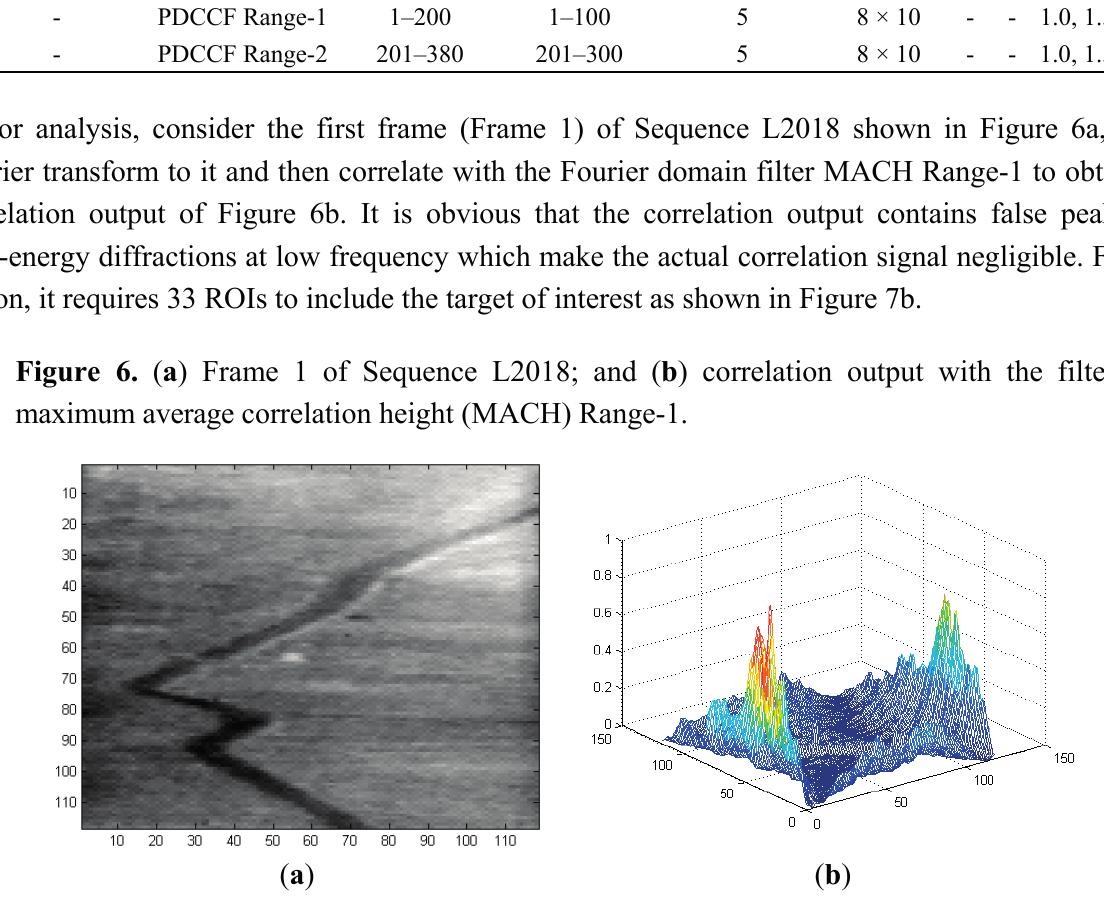
Figure 7. ( a ) 32 ROIs in Frame 1 of Sequence L2018; and ( b ) 33 ROIs in Frame 1 of Sequence